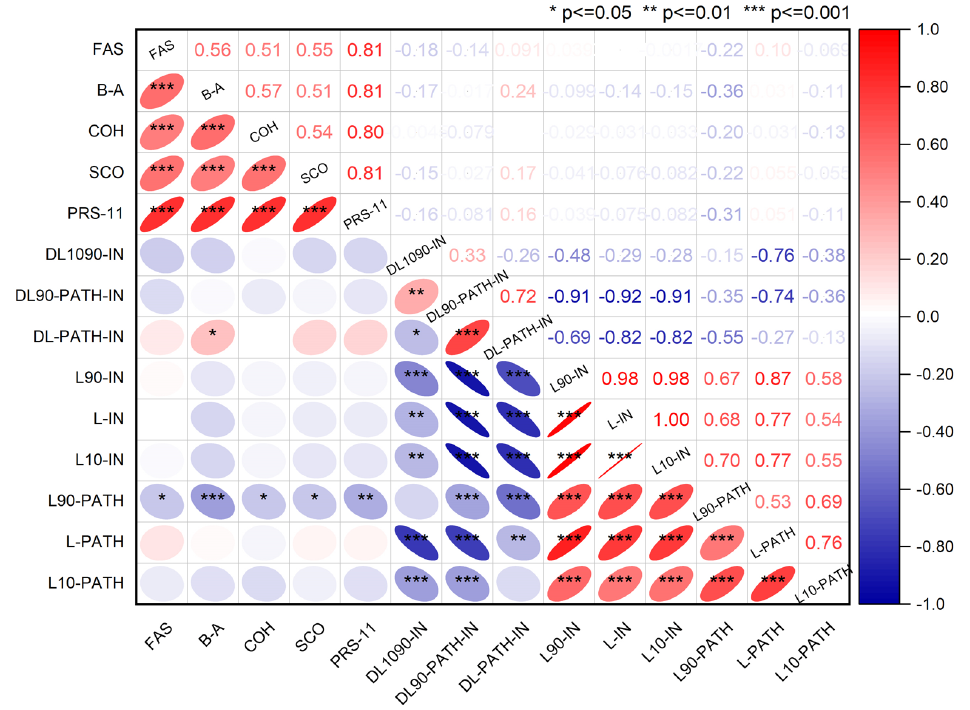
Figure 8: Pearson correlation matrices between the Perceived Restorativeness Scale (PRS-11) and its components: Fascination (FAS); Being- Away (B-A); Coherence (COH) and Scope (SCO), and the Sound Pressure levels inside and outside the sites